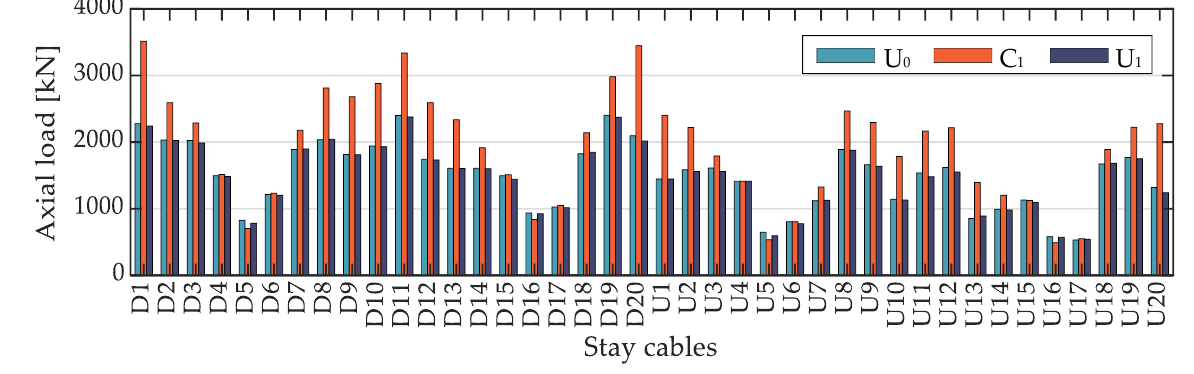
Figure 11. Experimental stay cable axial load variations during the C1 load configuration.